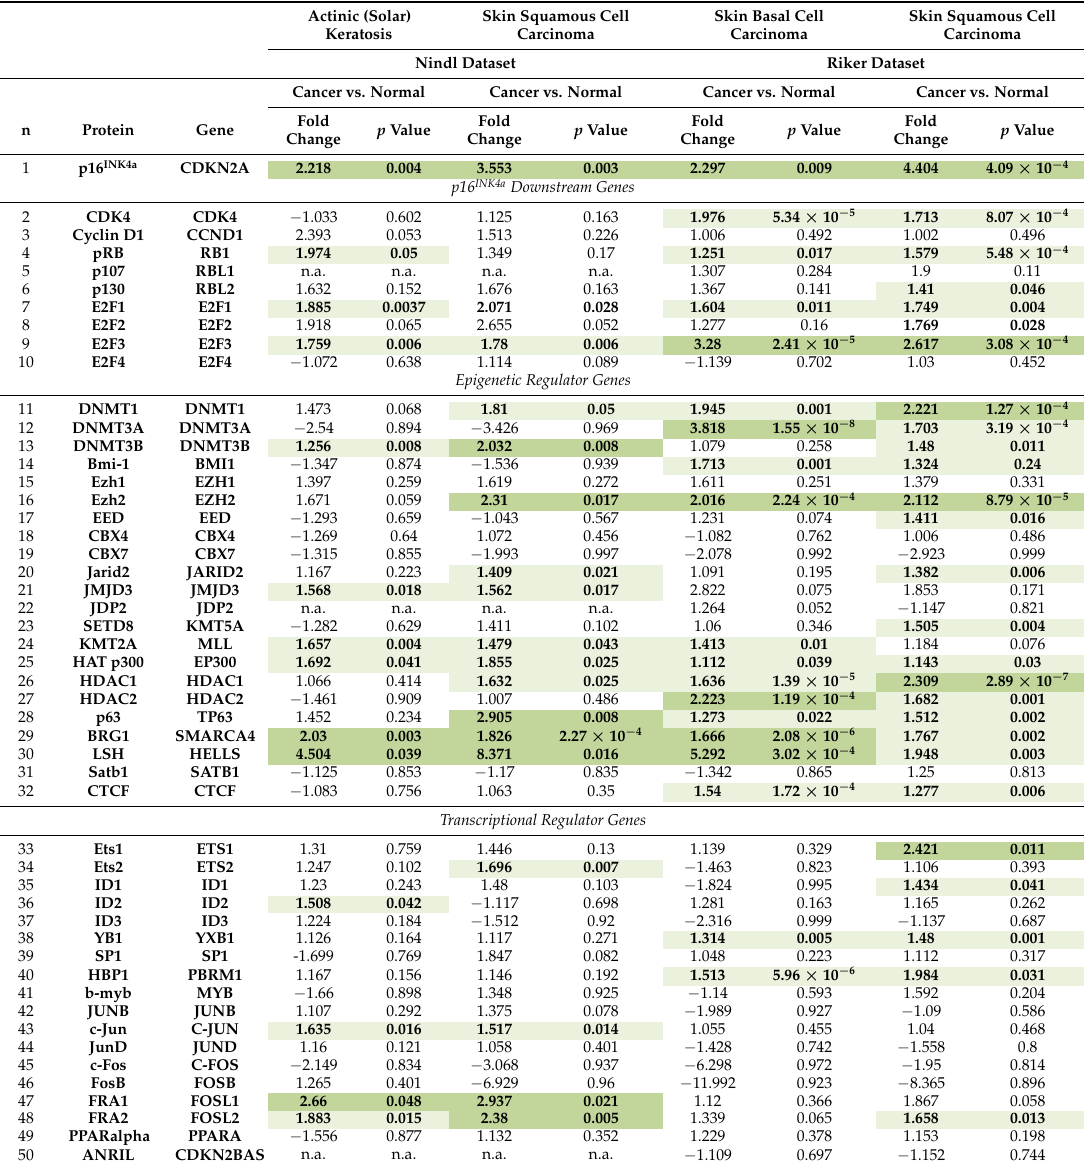
Table 2. Expression fold change of the genes investigated in the present study from Actinic (solar) Keratosis, Skin Squamous Cell Carcinoma, and Skin Basal Cell Carcinoma